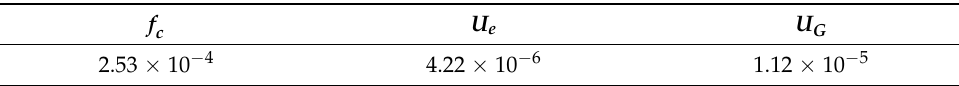
Table 7. Grid Convergence Index results.